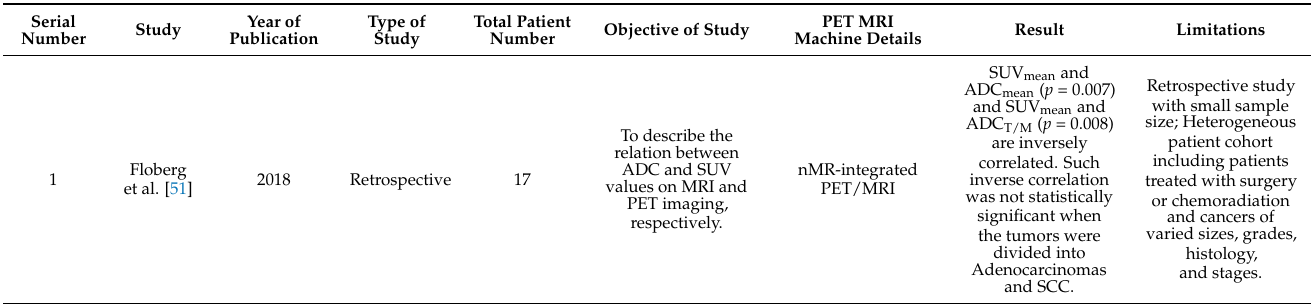
Table 3. Characteristics of PET/MRI studies in cervical